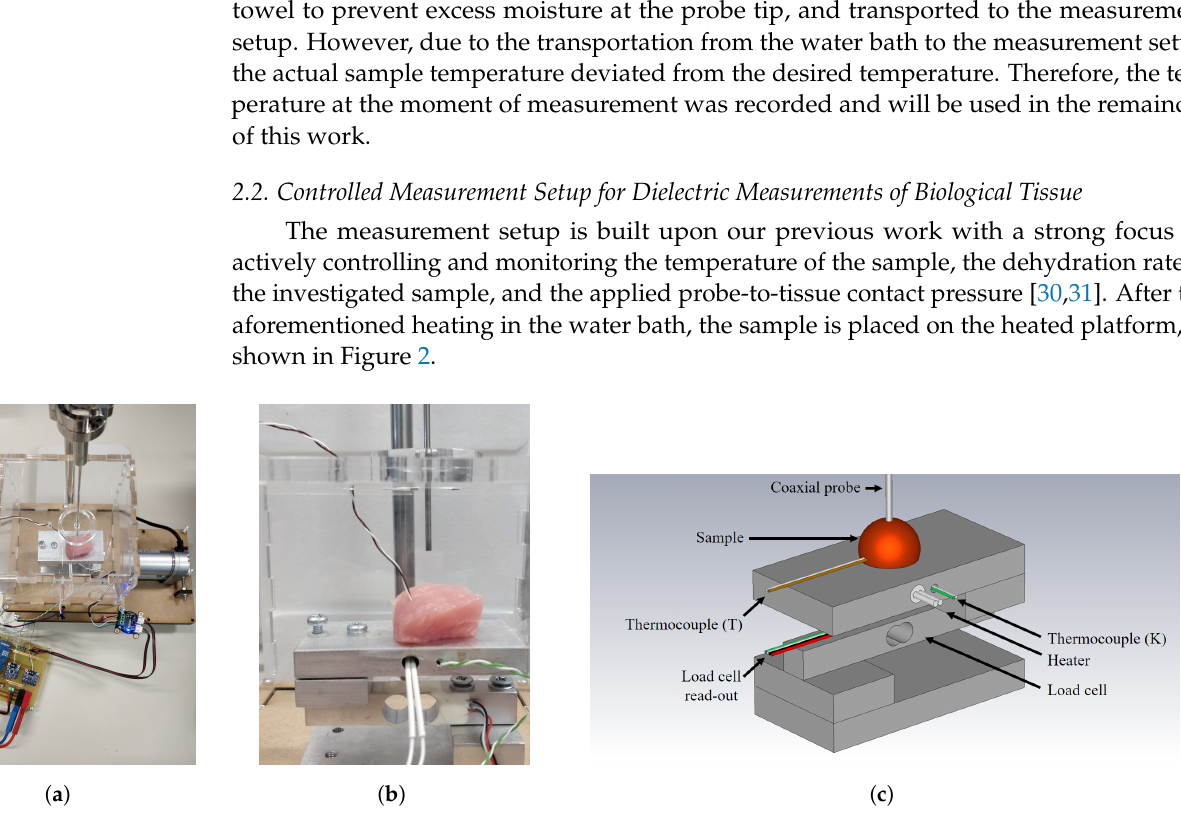
Figure 2. ( a ) Photograph of the controlled measurement setup. ( b ) Detailed photograph of the setup with a sample on the heated platform enclosed in a PMMA enclosure, ready to be probed for dielectric measurements. ( c ) Labeled, graphical representation of the measurement